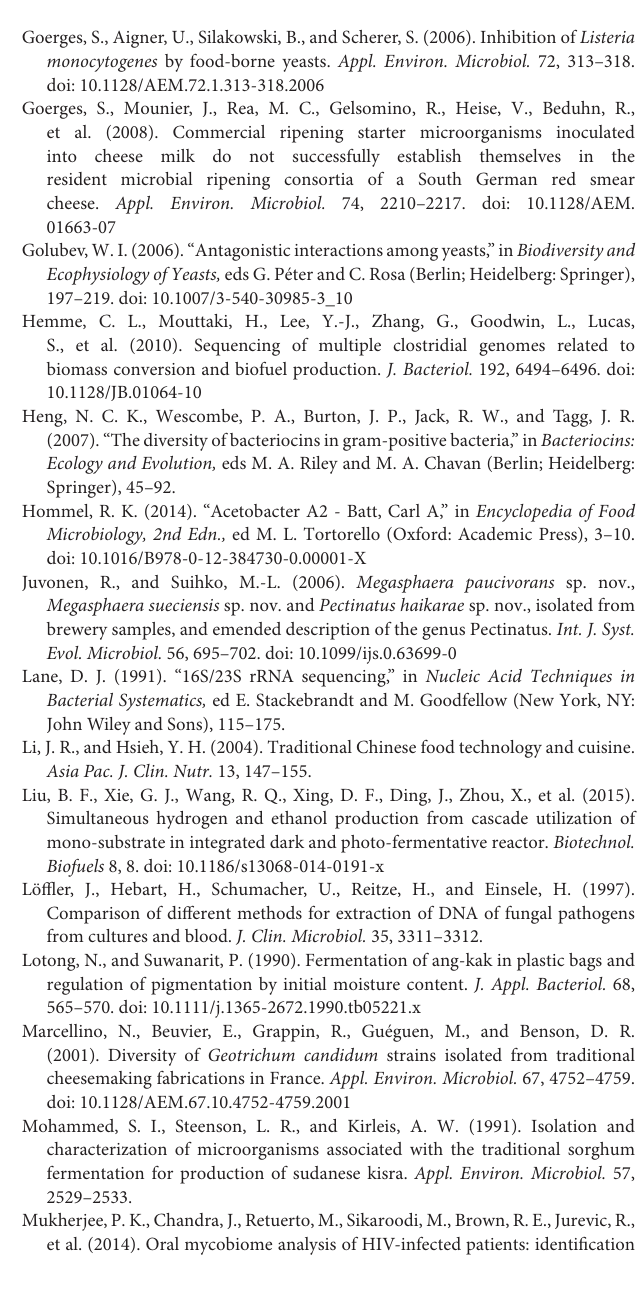
Table S1 | Biochemical analysis of the acid-gruel samples. Figure S1 | The collector retraction curves of the observed species, Chao1, and Shannon indice of the metagenomic libraries of the 24 Suanzhou samples. Figure S2 | The OTUs distributions in the 24 Suanzhou samples. Figure S3 | Growth curves of the isolated lactic acid